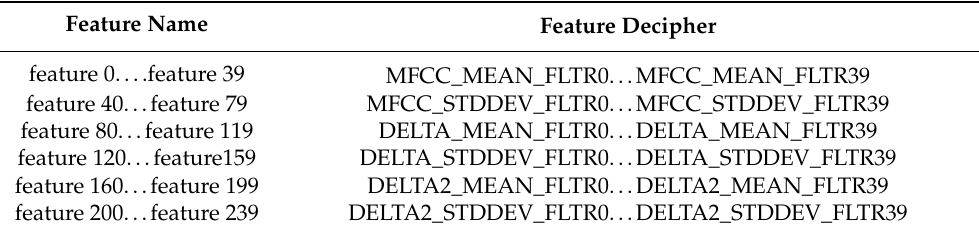
Table 2. Feature numbers and its associated meaning.